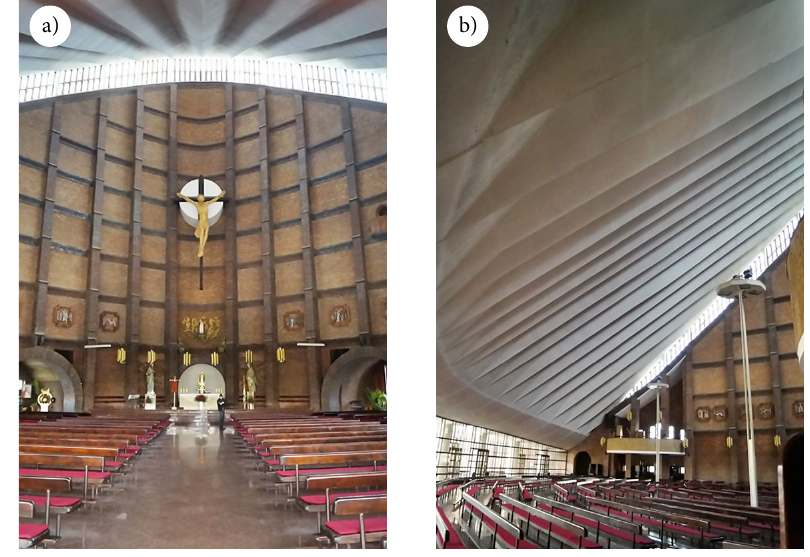
Figure 1. Photo of the church’s interior: a) a view from the nave towards the presbytery;